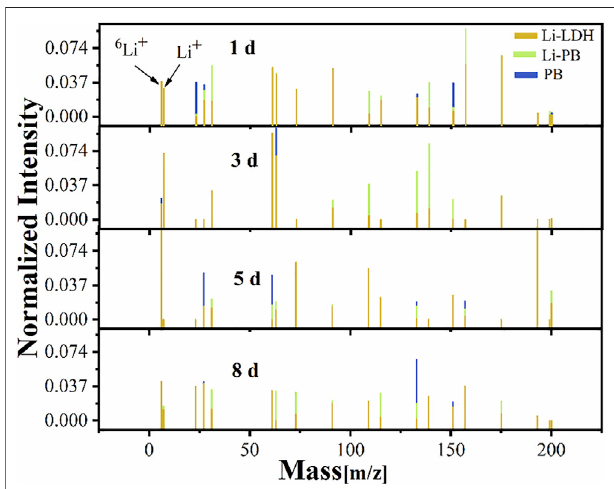
FIGURE8| ToF-SIMSandSEMimagesofthescratchedLi-AAO/epoxycoatinginthescratchedareaduringimmersionin3.5%NaClsolutionfrom1to8 days;the ToF-SIMS images are normalized to the total ion intensity.